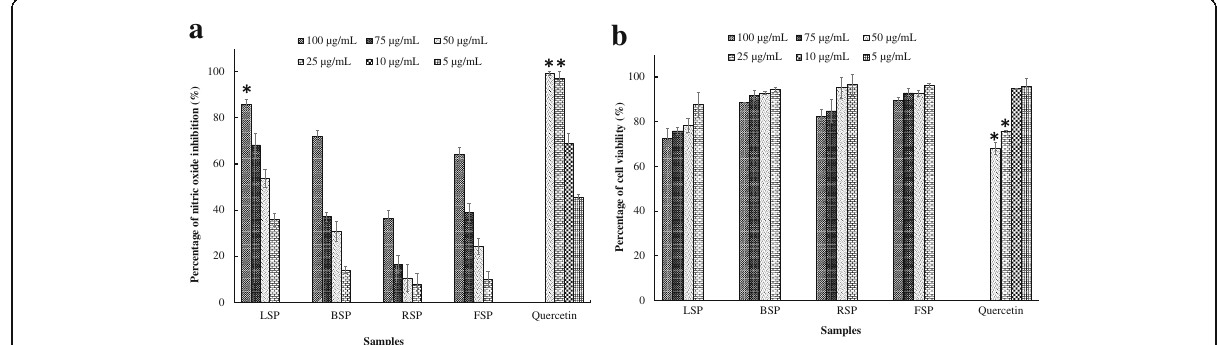
Fig. 1 Nitric oxide inhibitory activity of the extracts from S. pobeguinii on RAW 264.7 macrophages ( a ) with respect to their cell viability ( b ). Data represent the mean ± SE (standard error) of three independent experiments, * means significantly different (p ˂ 0.05). LSP: Methanol extract from leaves of S. pobeguinii , RSP: Methanol extract from roots of S. pobeguinii , FSP: CH 2 Cl 2 /MeOH (1:2) extract from fruits of S. pobeguinii , BSP: Methanol extract from bark of S.